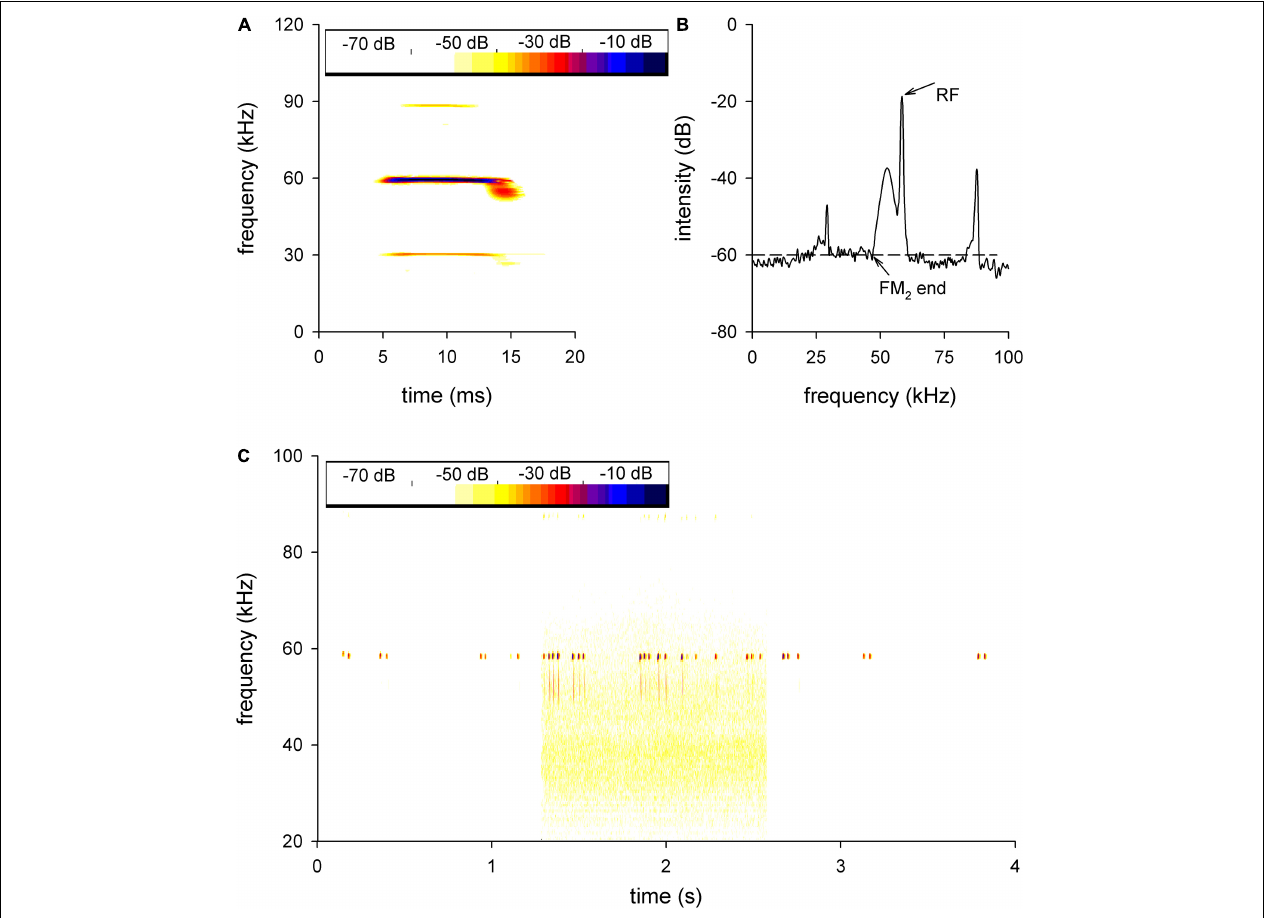
FIGURE 1 | The echolocation call of Hipposideros pratti . Sonogram (A) and power (B) spectrum of the echolocation call of H. pratti . H1, first harmonic; H2, second harmonic; H3, third harmonic. The second harmonic is the predominant component of the echolocation call of H. pratti . The dashed line in panel (B) shows the method of analysis for the FM 2 end frequency for H. pratti . RF, resting frequency; FM 2 , frequency modulation of the H2. (C) A representative echolocation trail of a bat before, during, and after exposure to background white noise, showing the nearly constant RFs and increased FM 2 bandwidth during the background noise. The yellow background is due to the